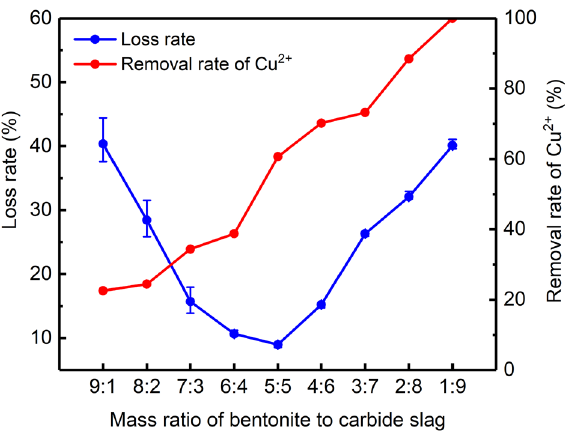
Figure 1. Loss rate and Cu 2+ removal rate for particles with different mass ratios of bentonite to carbide